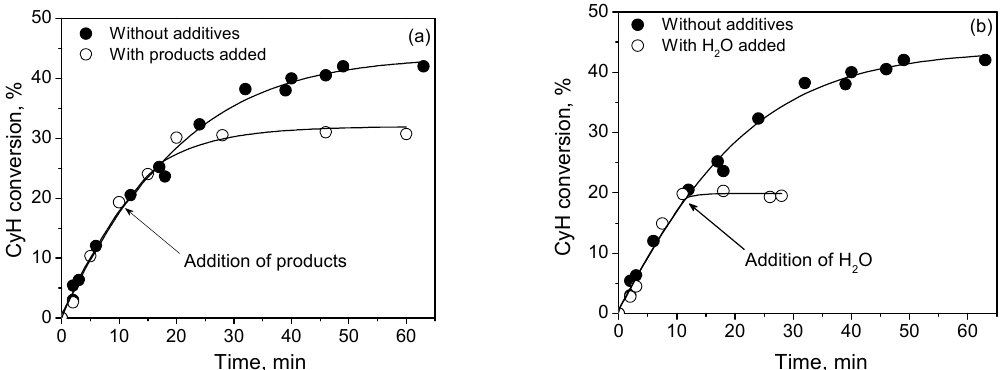
Figure 5. The effect of the addition of reaction products on the course of CyH oxidation with H 2 O 2 in the presence of 1 equivalent of HClO 4 over MIL-125-L. Reaction conditions: CyH 0.1mmol, H 2 O 2 0.1 mmol, catalyst 0.01 mmol Ti, HClO 4 0.01 mmol, CH 3 CN 1 mL, 50 ◦ C, ( a ) epoxide 0.015 mmol and diol 0.015 mmol or ( b ) water 0.3 mmol added at ca. 20% CyH conversion.